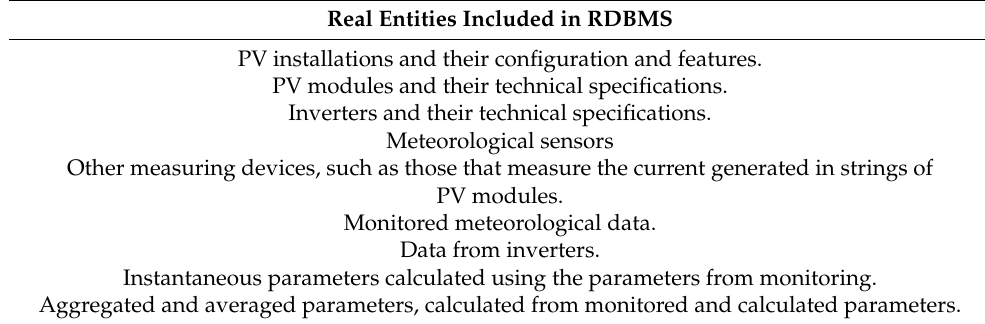
Table 1. Real entities included in the Relational Data Base Management System (RDBMS) imple- mented in this paper for the analysis of PV